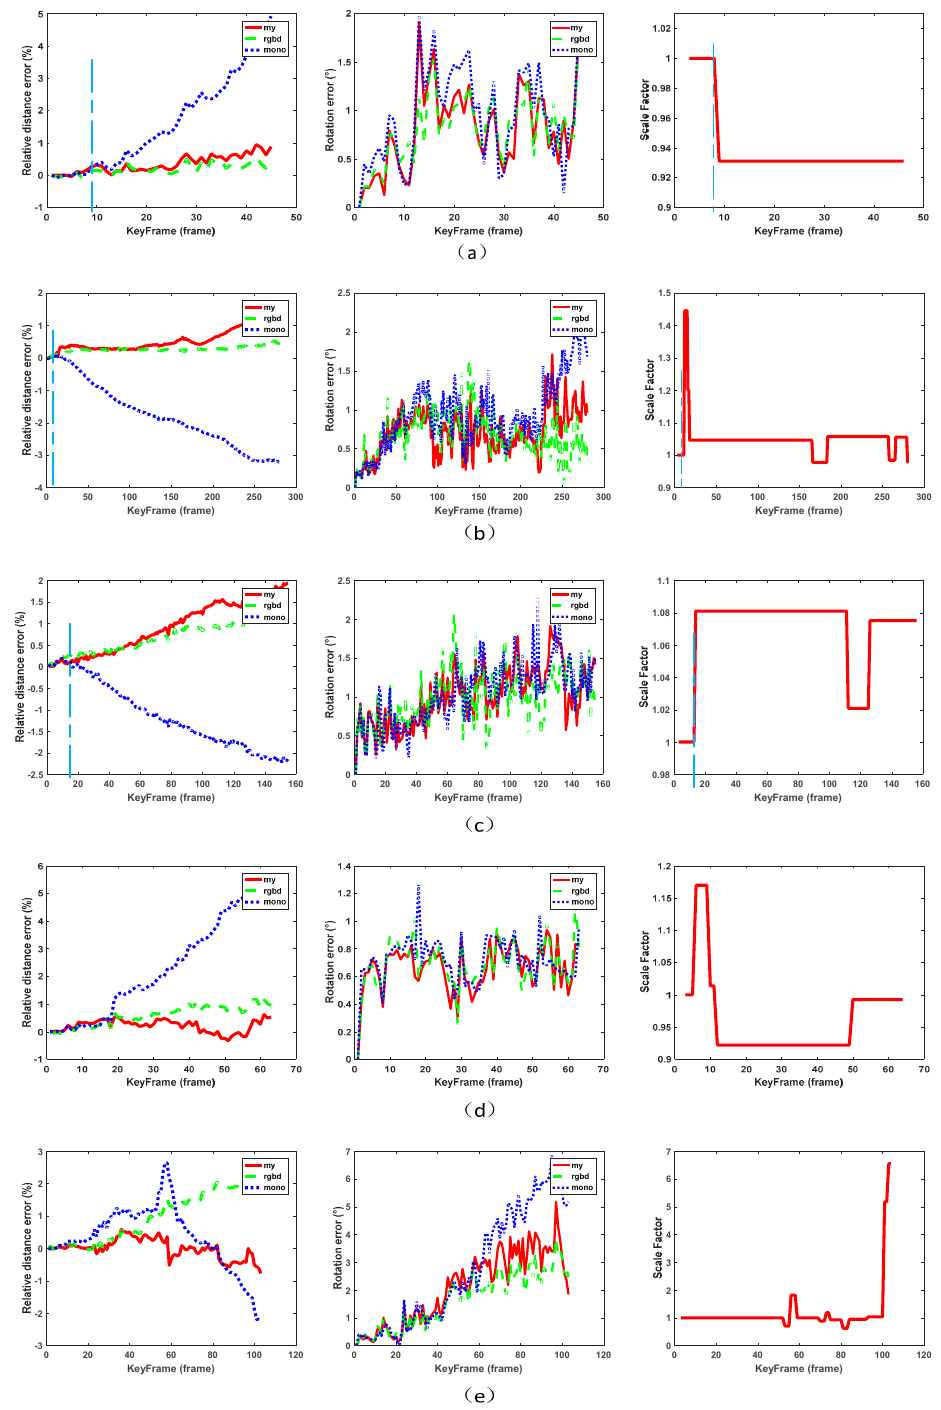
Figure 6. Error assessment results. The horizontal rows of three charts respectively indicate, the relative distance error, the rotation error, and the change curve of the scale estimate. Each row of the data corresponds to a data sequence. ( a ) fr1/xyz; ( b ) fr3/office; ( c ) fr3/near; ( d ) fr3/xyz; ( e ) fr1/teddy. In Figure 6b,d, there are also significant situations like this. A similar effect to RGBD camera is achieved in the final distance estimation error. For the rotation errors, all three methods are based on